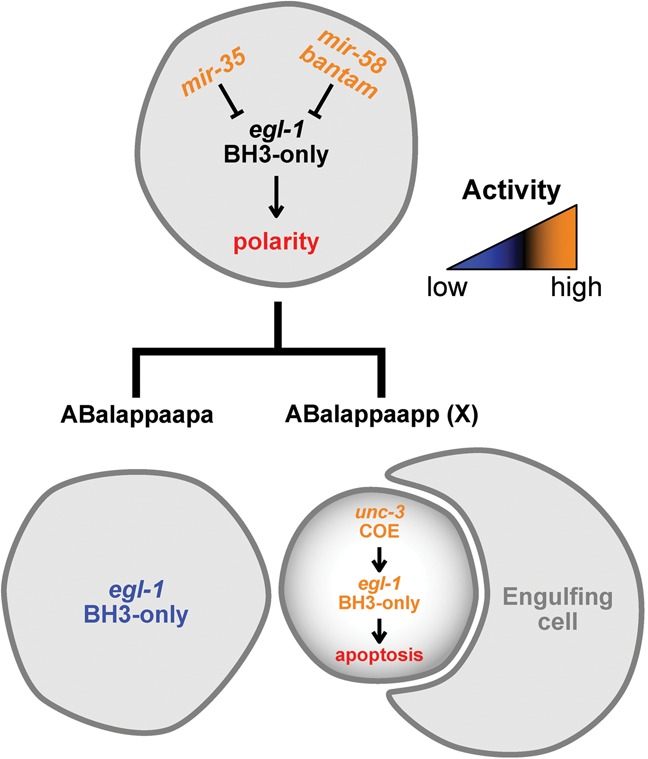
Genetic model of mir-35- and mir-58-dependent control of egl-1 BH3-only in the ABalappaap lineage. See the text for details.